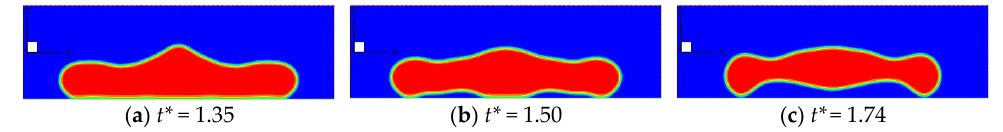
Figure 4. The contours of the coalesced droplet along the center line of the y -direction on the S1 surface. ( a – c ) Corresponds to the moments shown in Figure 3f–h.